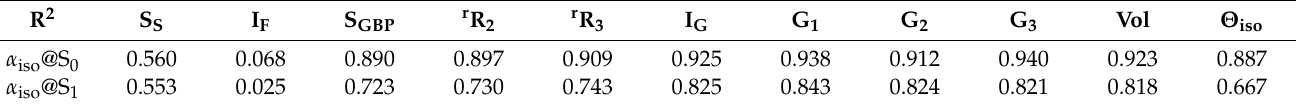
Table 4. Correlation coefficients (R 2 ) between the ground-state ( α iso @S 0 , in Bohr 3 ) or the first excited- state ( α iso @S 1 , in Bohr 3 ) molecular polarizability, and molecular volume (Vol, in Bohr 3 /mol), the isotropic quadrupole moment ( Θ iso , in a.u.), and ITA quantities (in a.u.) based on the transition density matrix as an input for all the systems in Schemes 1 and 2.